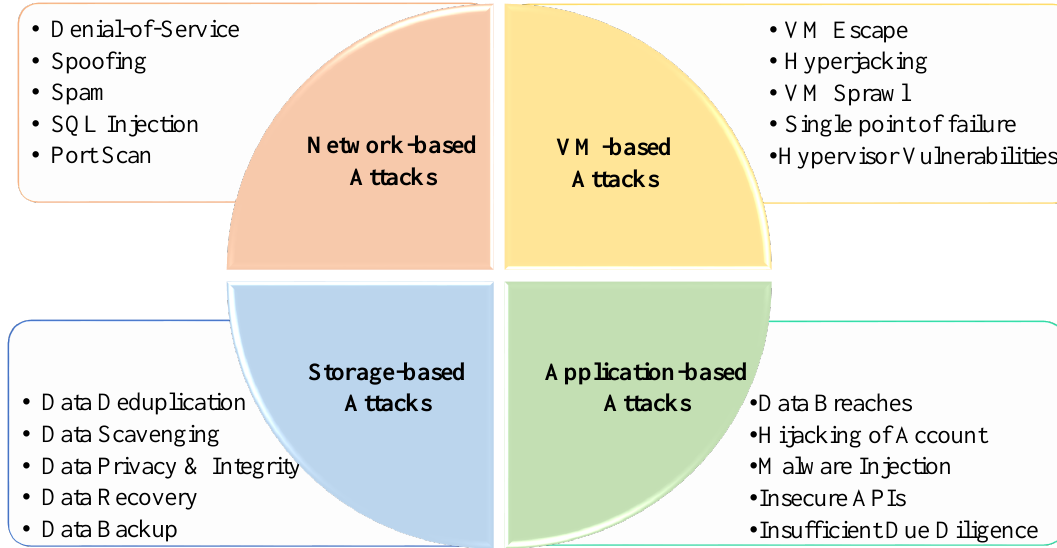
Figure 4. Attacks on cloud